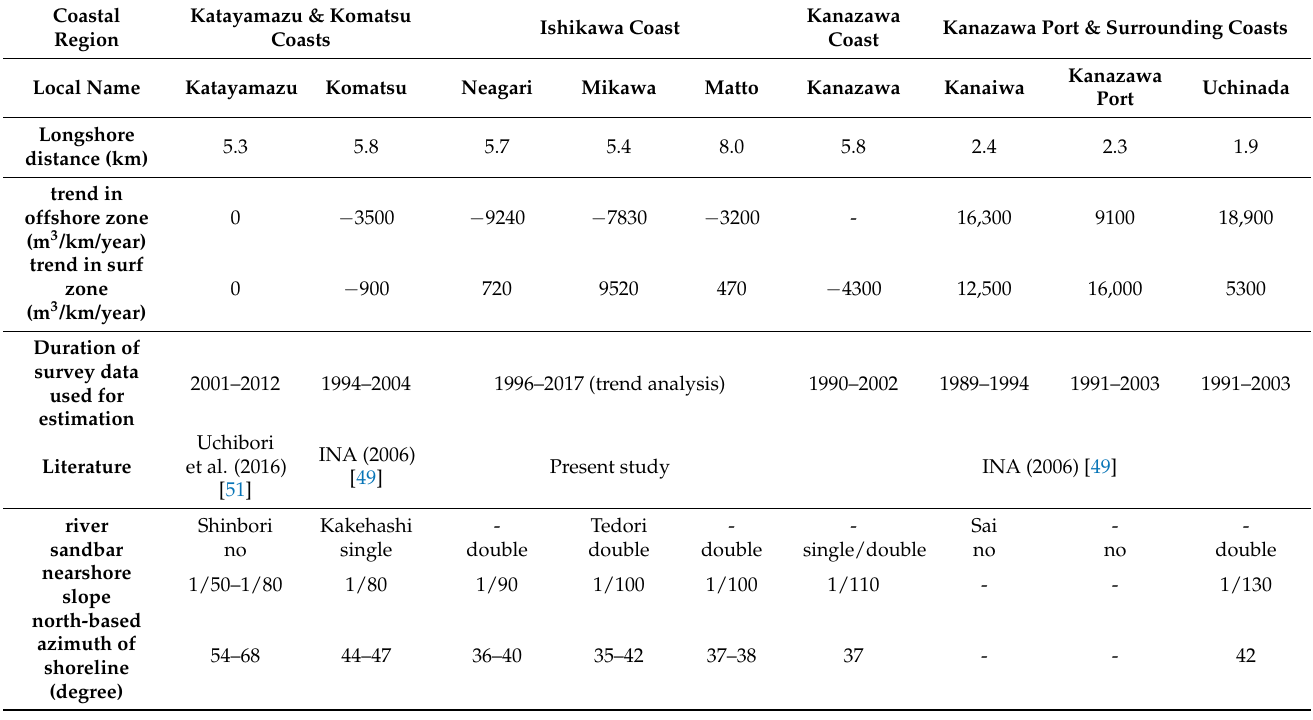
Table 4. Trend of sediment yield and morphological characteristics of the southern part of the littoral sediment cell (SLC) analyzed in this study. The duration of survey is shown, as well as coast information including such sandbar type, cross-shore slope, and north-based azimuth of